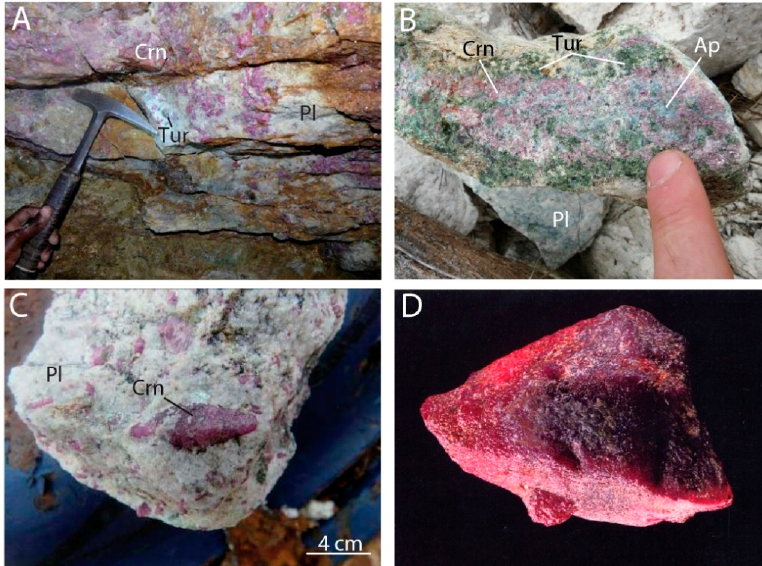
Figure 39. The ruby-bearing rocks of the John Saul mine, Voi area, Kenya [118,163]. ( A ) The Kimbo Pit and its ruby-bearing plumasite showing the mineral assemblage ruby (Crn), plagioclase (Pl), and some tourmaline (Tur); ( B ) concentration of ruby, green tourmaline, and blue apatite (Ap) in the plagioclase vein of the Kimbo Pit; ( C ) ruby showing the scalenohedron habit in the plagioclase matrix of the plumasite, Kimbo Pit; and ( D ) mushroom habit of a ruby, 3 cm across, from the John Saul mine. Photos A–C: Gaston Giuliani; Photo D: Courtesy John Saul.